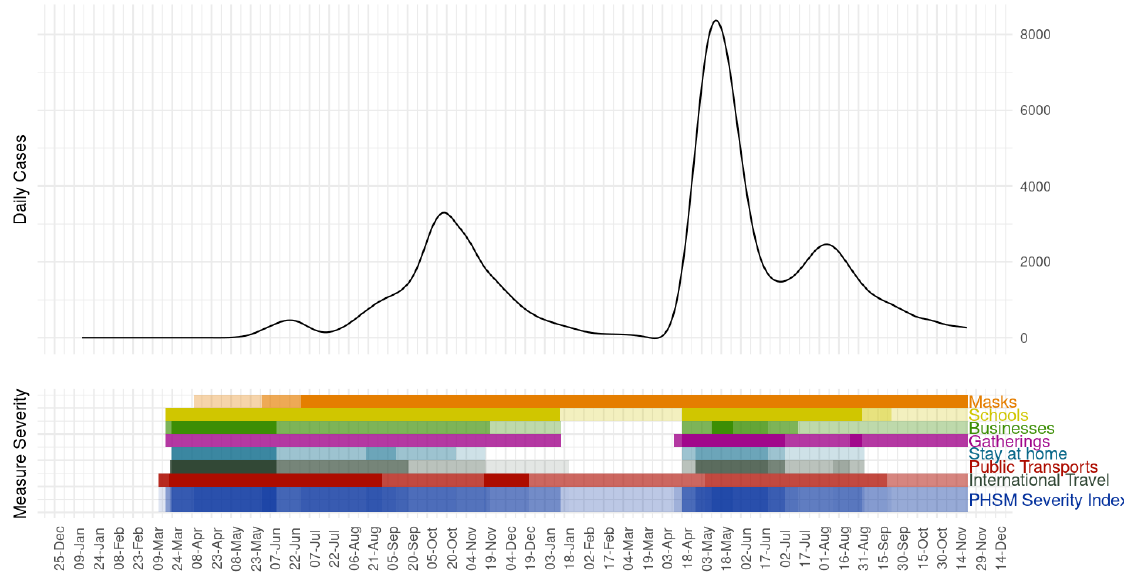
Figure 13. Daily COVID-19 cases over severity of public health and social measures (PHSM) in Nepal (March 2021– 23 November 2021). Figure source: PHSM dashboard published by WHO regional office for South East Asia [58]. Indicators and PHSM severity index are assigned a color. The shading of that color is based on the severity score. The darkest shade represents the most severe measure/s (value of 100) and a lack of color represents no measure (value of